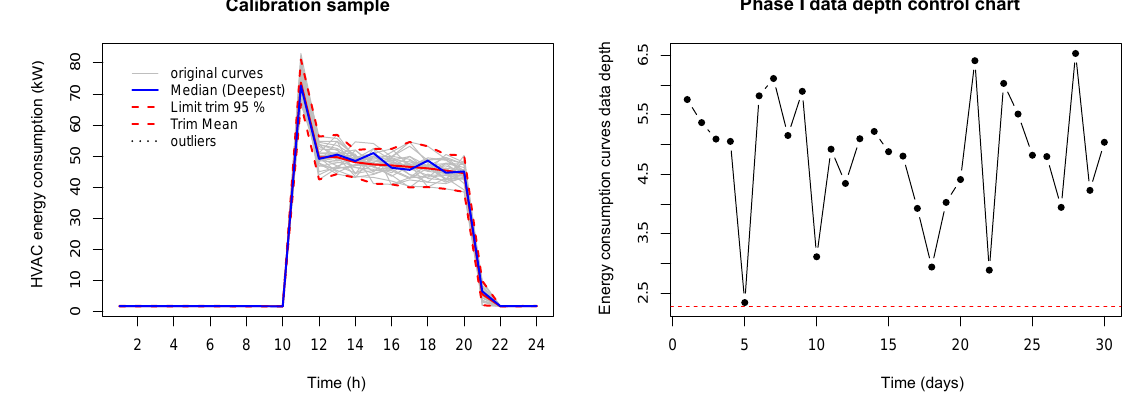
Figure 5. Under-control process (HVAC energy consumption is stabilized). Left panel: daily HVAC energy consumption curves in the Panama City store, showing the envelope corresponding to 95% of deeper curves. Right panel: control chart for Phase I based on functional data